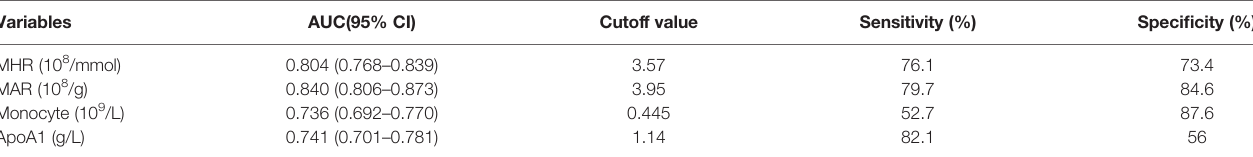
TABLE 6 | ROC Curve Analysis of MHR and MAR in identifying MetS.